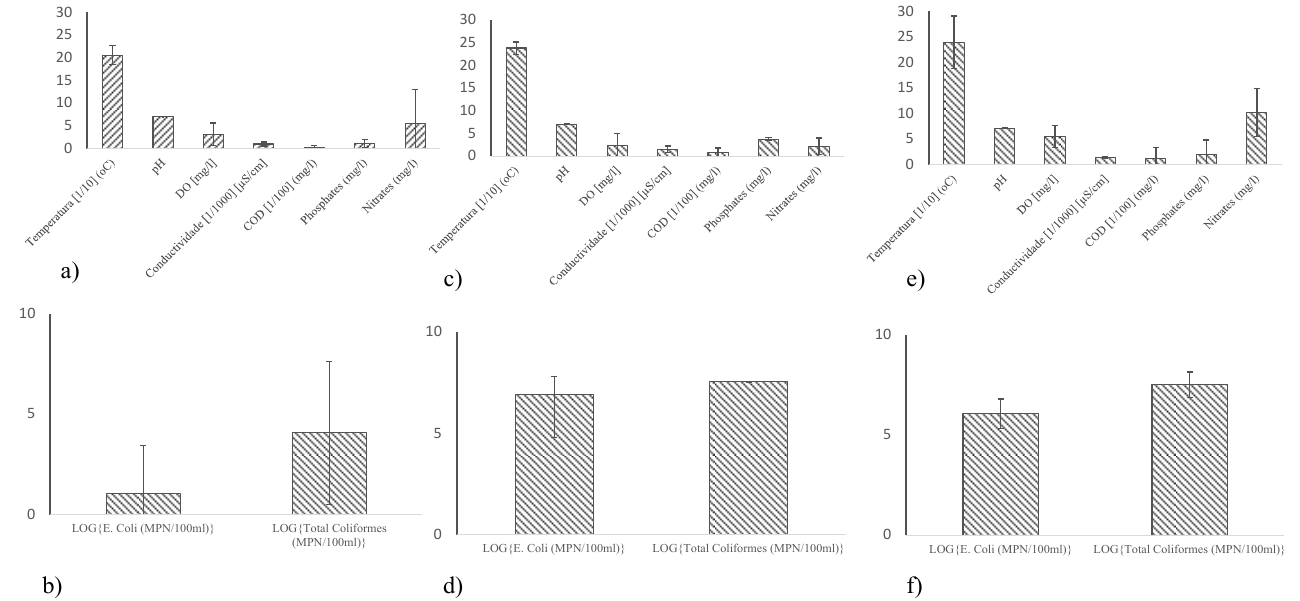
Figure 5. Results of water quality parameters from Group I: ( a ) Standard water quality parameters, including Dissolved oxygen (DO), Chemical Oxygen Demand (COD), nitrates and phosphates in river water; ( b ) Biological parameters in river water; ( c ) Standard water quality parameters, including DO, COD, nitrates and phosphates in the outlets of wastewater treatment plants (WWTPs); ( d ) Biological parameters in the outlets of WWTPs; ( e ) Standard water quality parameters, including DO, COD, nitrates and phosphates in the drainage water; ( f ) Biological parameters in the drainage water.